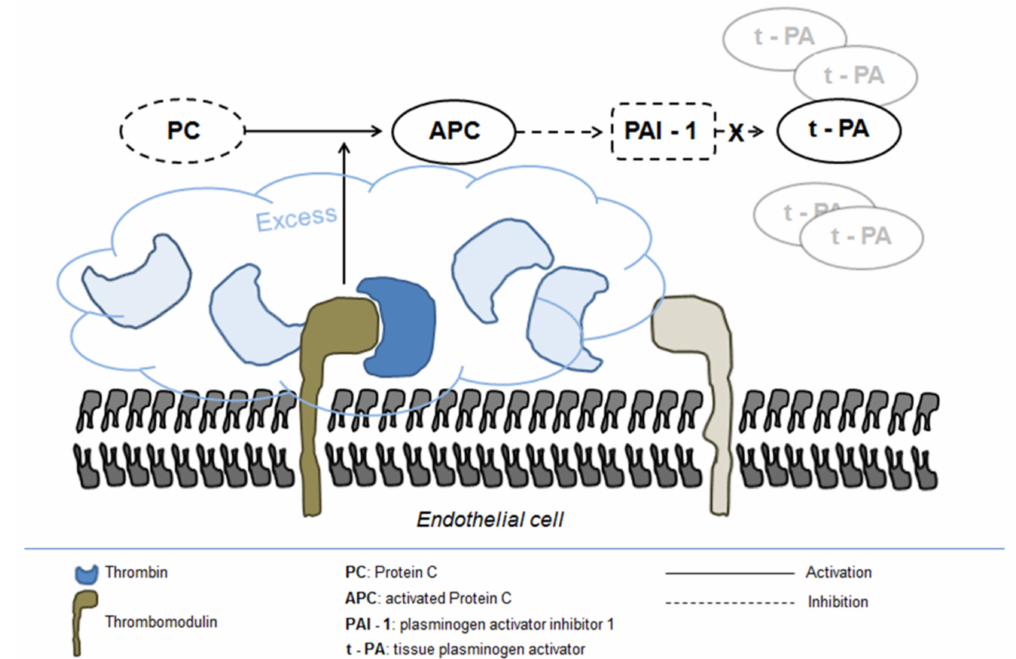
Figure 2. Fibrinolysis activation in severe